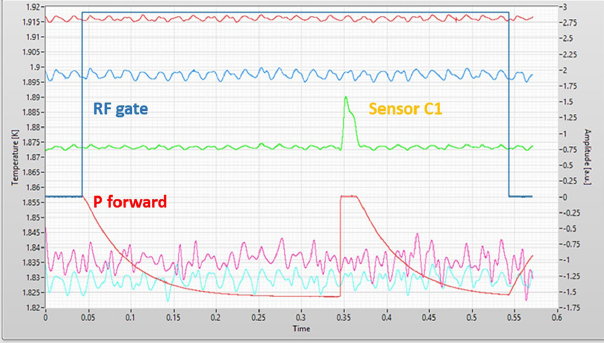
FIG. 7. Fast temperature sensors readout at the quench field. rf gate (violet) and transmitted power (red) and the sensor at the defect position (green) are